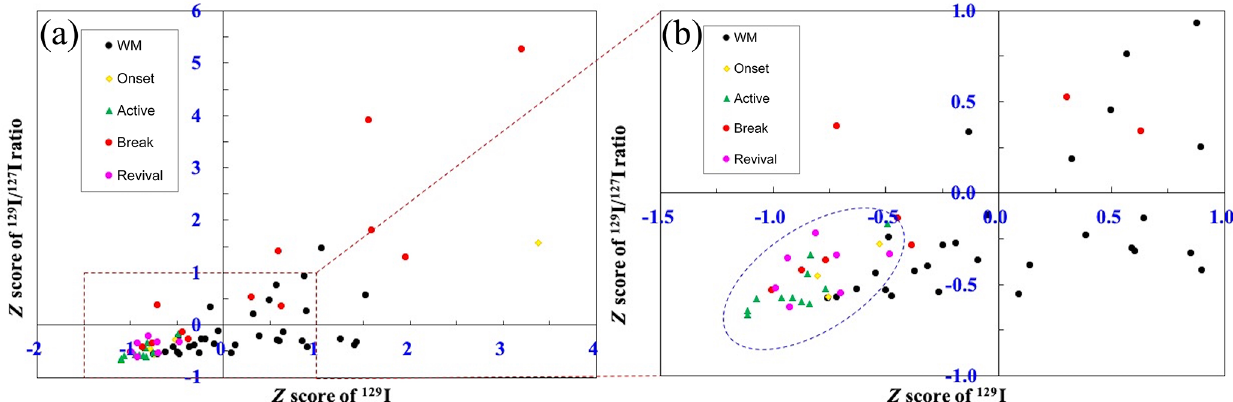
Figure 6. Two-dimensional graph of Z -score-normalised 129 I concentrations and 129 I / 127 I number ratios, suggesting the refined features of the East Asian summer (onset, active, break and revival in yellow diamond, green triangle, red circle and pink circle, respectively) and winter monsoons (WM; black dot) (a) . The coloured symbols clearly demonstrate a detailed onset-active-break-revival cycle for the summer ≤ − 0 . 5 and Z ≤ 0, as illustrated in the blue oval area (b) monsoon with Z 129 Ratio I